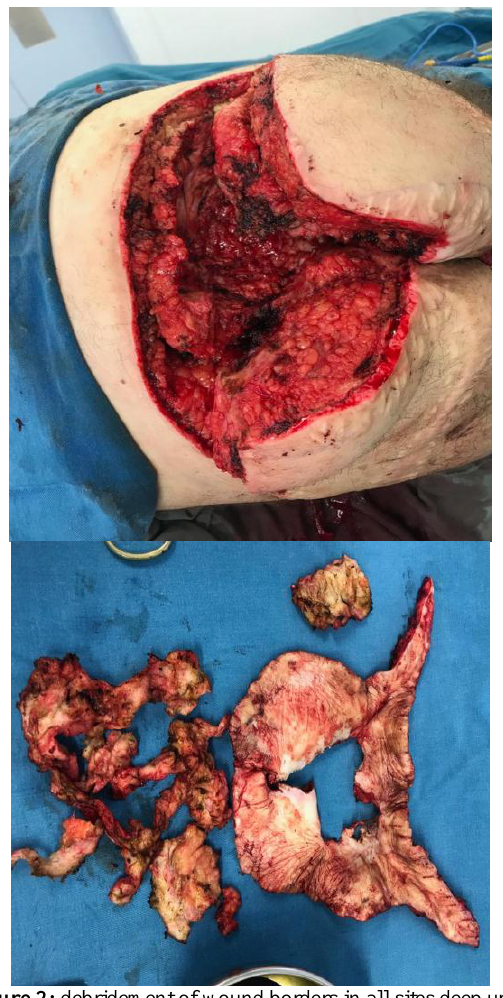
Figure 2: debridement of wound borders in all sites deep up to the sacrum, with all unviable tissue removed